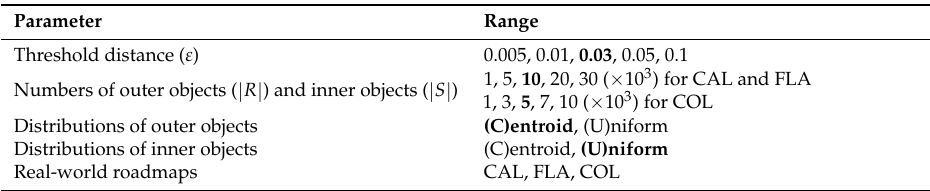
Table 6. Experimental parameter